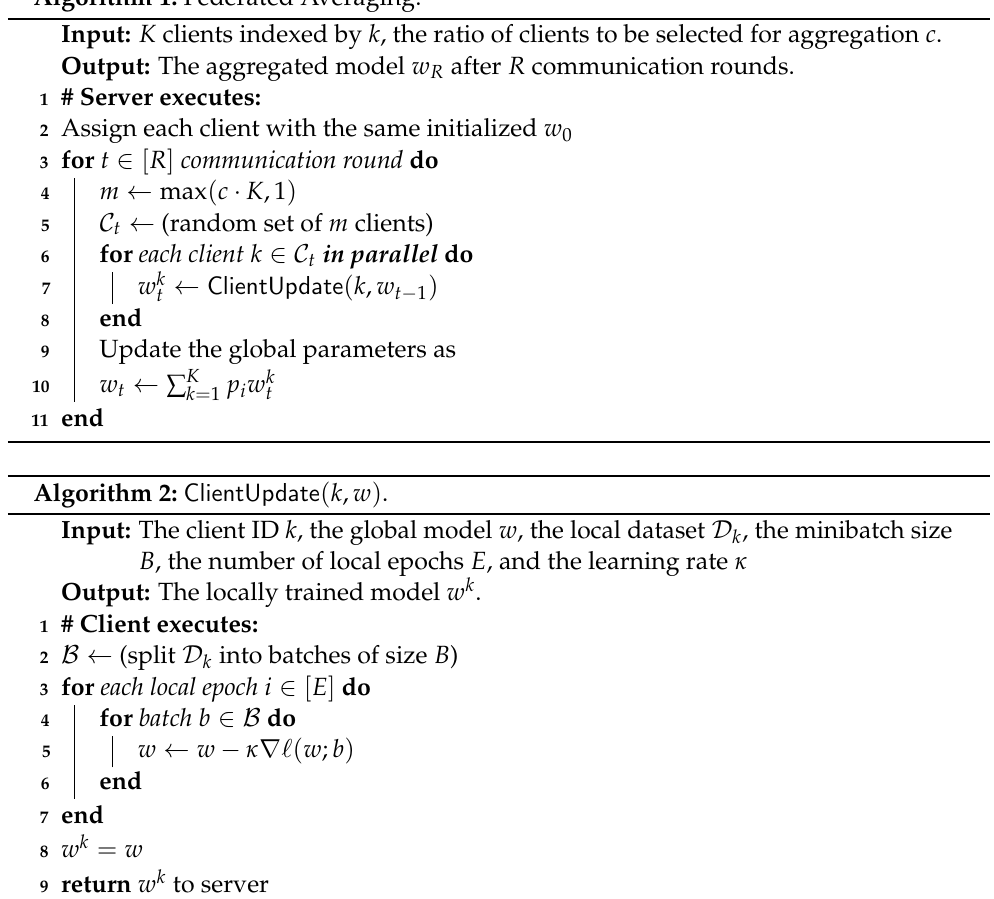
Algorithm 1: Federated Averaging.